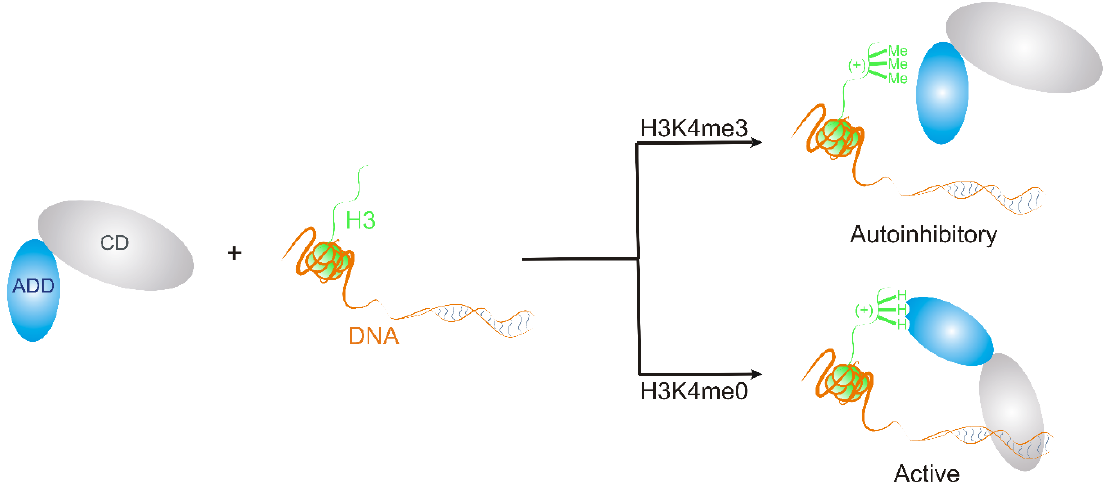
Figure 7. A schematic representation of the effect of H3K4me3 trimethylation on DNMT3A enzyme activity. In the presence of H3K4me3 PTM, the DNMT3A enzyme is in an autoinhibitory form. In the case of the non-methylated H3K4me0, the enzyme interacts with the DNA in an active form where the arrangements of its ADD and CD domains is different from that in the autoinhibitory form.